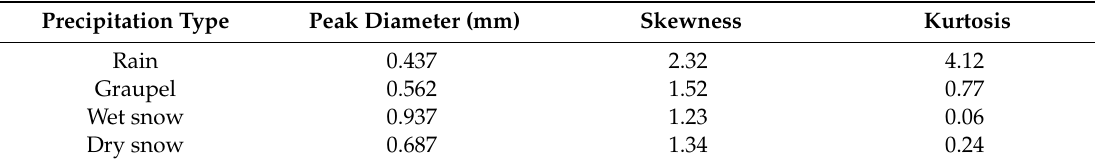
Figure 3. The mean PSDs of rain, graupel, wet snow and dry snow. Table 3. Peak diameters, skewness and kurtosis of particle size distribution (PSD) for di ff erent types of